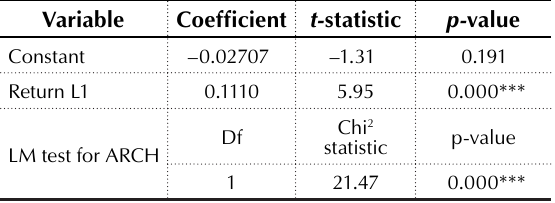
Table 2. LM test for autoregressive conditional